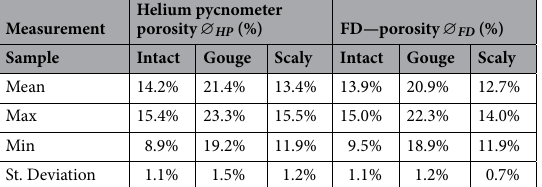
Table 2. Porosity results of intact, scaly clay and fault gouge Opalinus Clay